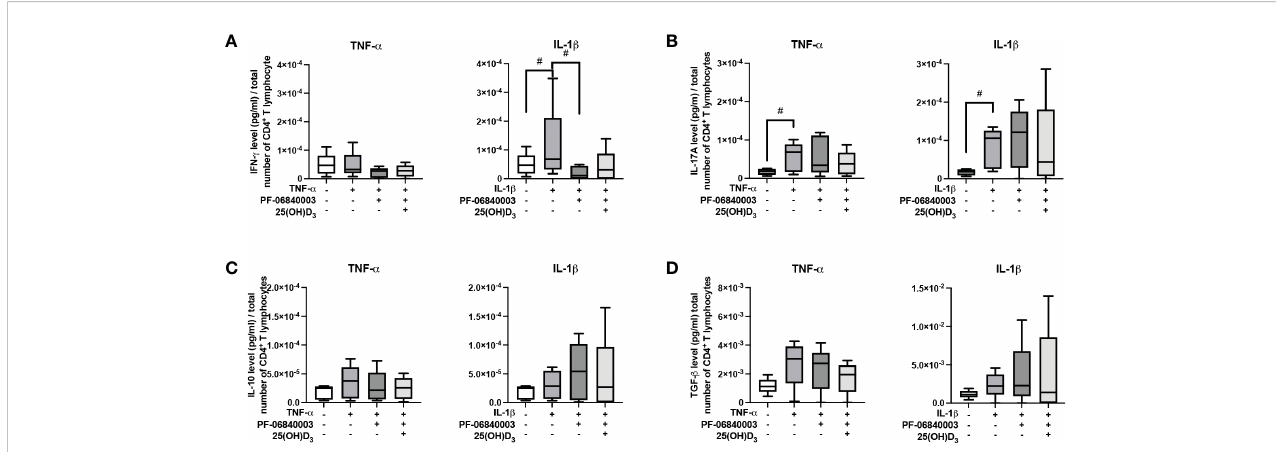
FIGURE 7 In fl uence of IDO-1 pharmacological inhibition on the production of IFN- g , IL-17A, IL-10, and TGF- b in CD4 + T lymphocytes in the presence of hPDL- MSCs under different cytokine conditions. After fi ve days of indirect co-culture with hPDL-MSCs, the concentrations of IFN- g (A) , IL-17A (B) , IL-10 (C) , and TGF- b (D) were measured in conditioned media using appropriate ELISAs and the total CD4 + T lymphocyte numbers per sample were determined using a cell counting chamber. Measured cytokine levels (pg/ml) were normalized to the total CD4 + T lymphocyte number. Data were obtained from fi ve (A-D) experimental repetitions using hPDL-MSCs from a different individual per repetition. One technical replicate was used per experimental group. The normalized cytokine levels were presented as a box-whisker plot showing the minimum and maximum values (A-D) . The Friedman test, followed by the Wilcoxon test, was used for pairwise comparison. # p-value < 0.05 were considered to be statistically signi fi cant between groups as